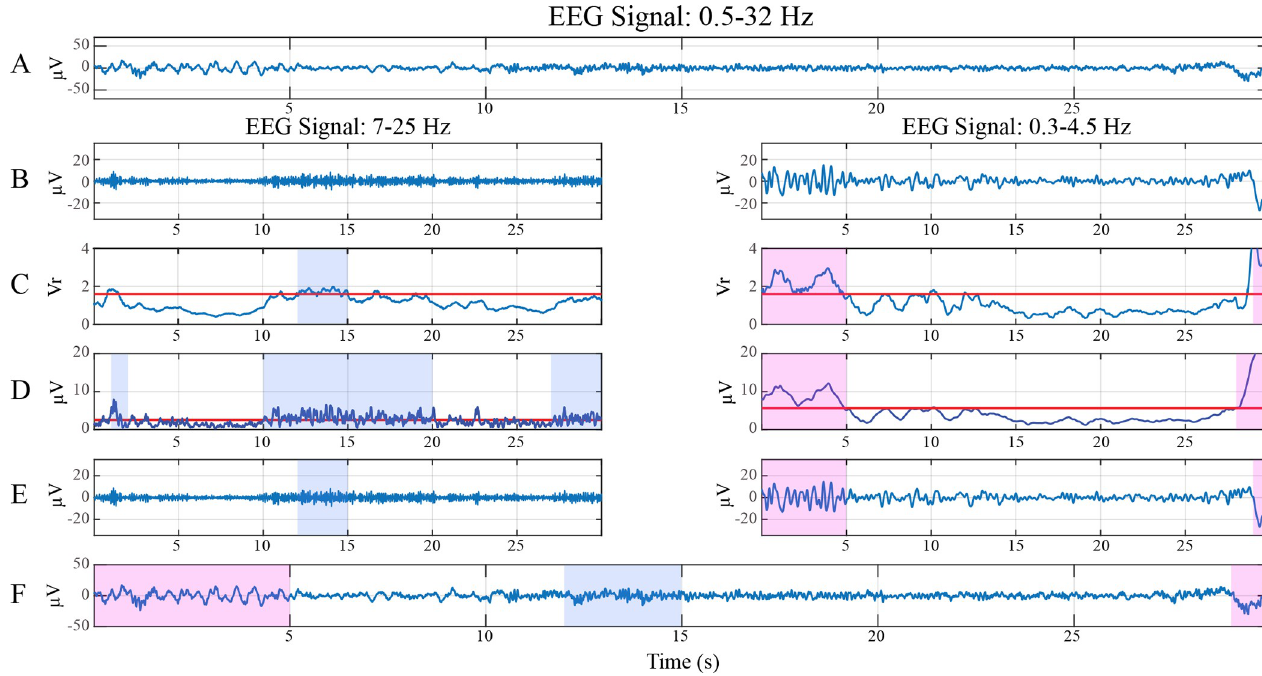
Fig 1. Graphic representation of the adapted Ferri’s algorithm. The raw EEG signal (A) was digitally band-pass filtered in the slow (B, right panel) and fast (B, left panel) frequency range (slow: 0.3–4.5 Hz; fast: 7–25 Hz). C) For each frequency band of interest, all seconds of the EEG signal with a variability measure 1.6 times (red line) higher than the variability of the corresponding 90-s epoch were marked. D) All seconds of the EEG signal with an envelope higher than the RMS threshold (red line) were marked. The common seconds identified in C and D represent the CAP A events (E), highlighted in (F) on the RAW EEG signal (pink frame: slow events; blue frame: fast